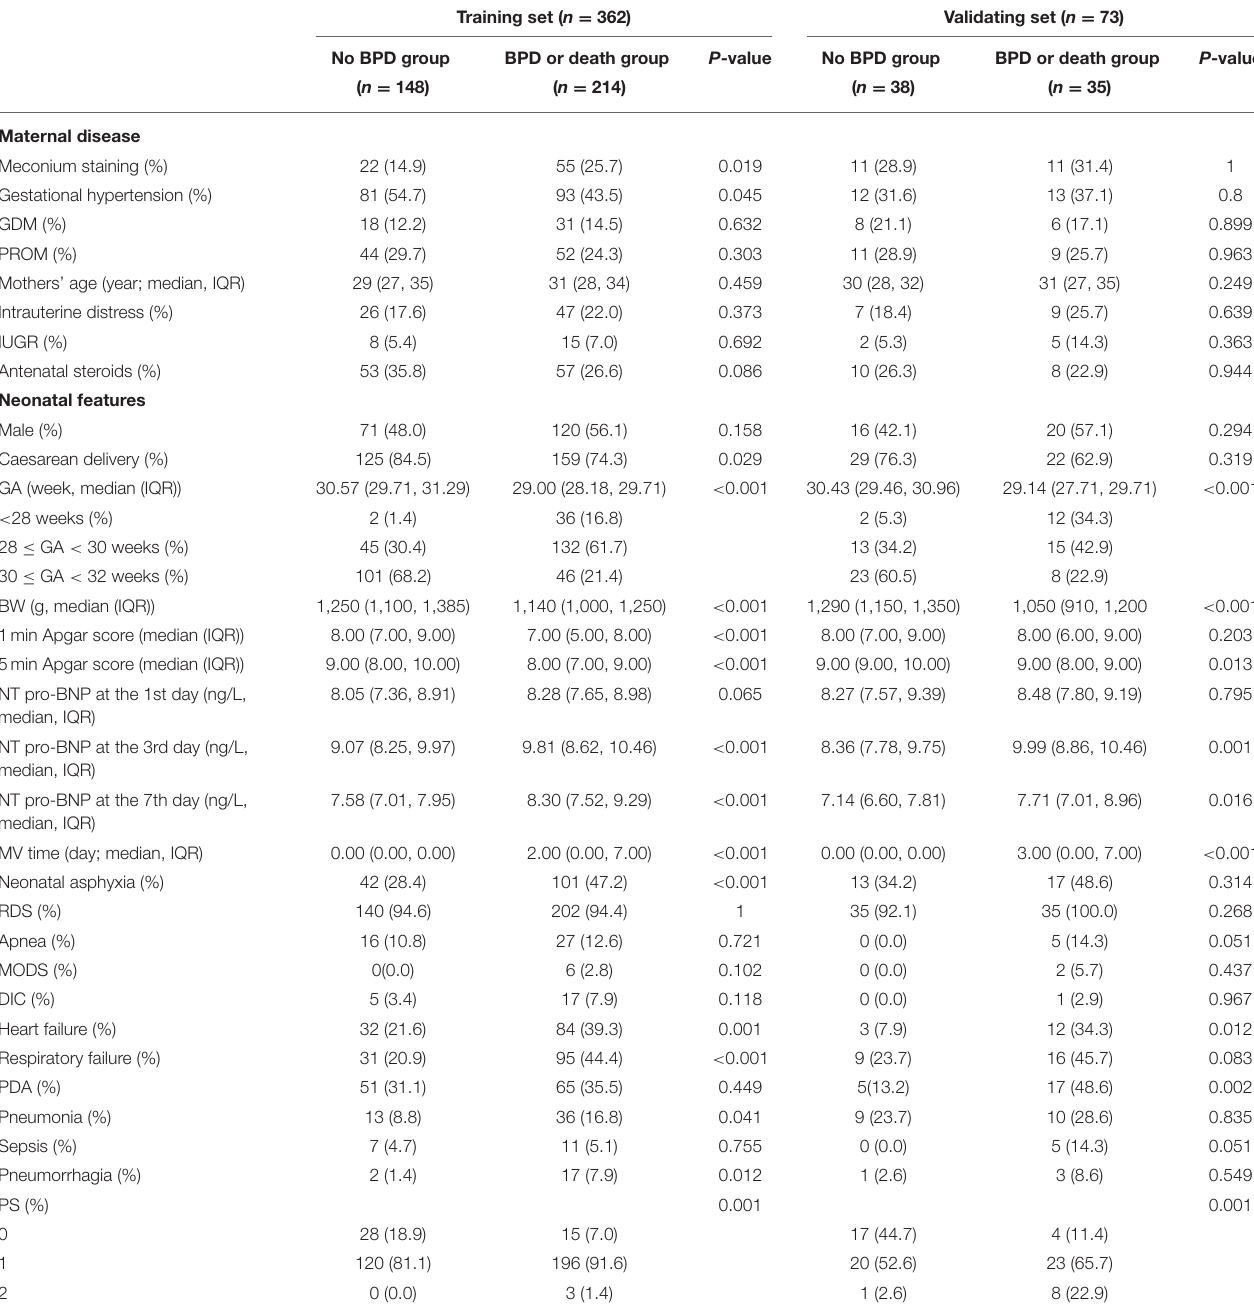
TABLE 1 | Clinical features in